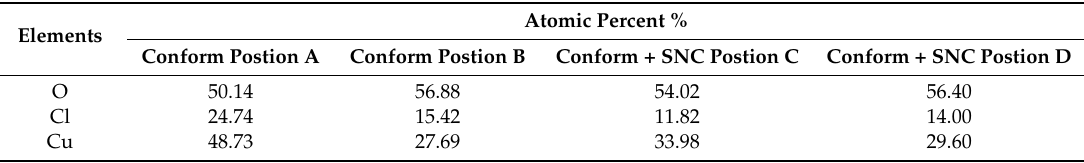
Table 3. Energy dispersive X-ray spectrometer (EDS) analysis of corrosion products on the surface of Conform and Conform + SNC specimens immersed in 0.1 M NaCl solutions for 30